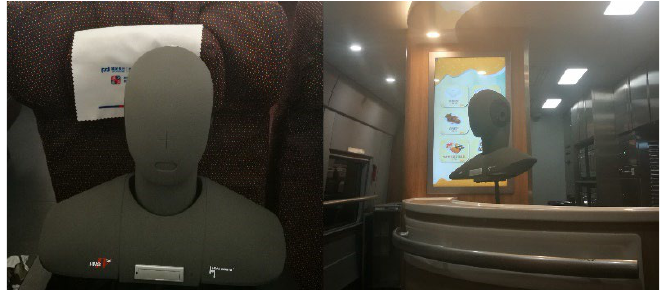
Figure 3. Experimental setup of the artificial head.